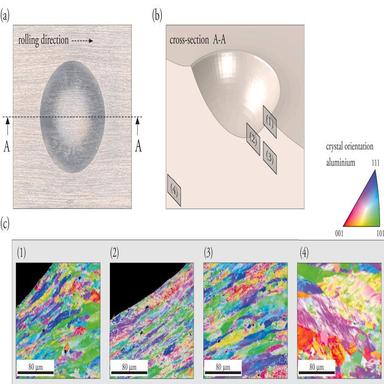
The analysis of the indented sheet microstructure: the residual imprint (a) was cut along rolling direction and analysed for the microstructure at 4 different locations (b): at pile-up area (c-1), beneath the indenter in the surface area of strong plastic flow (c-2), under the indenter in the deformation zone (c-3). The location (c-4) corresponds to the microstructure of the undeformed material. Since the area affected by the indenter is significantly larger than the average grain, this confirms the applica